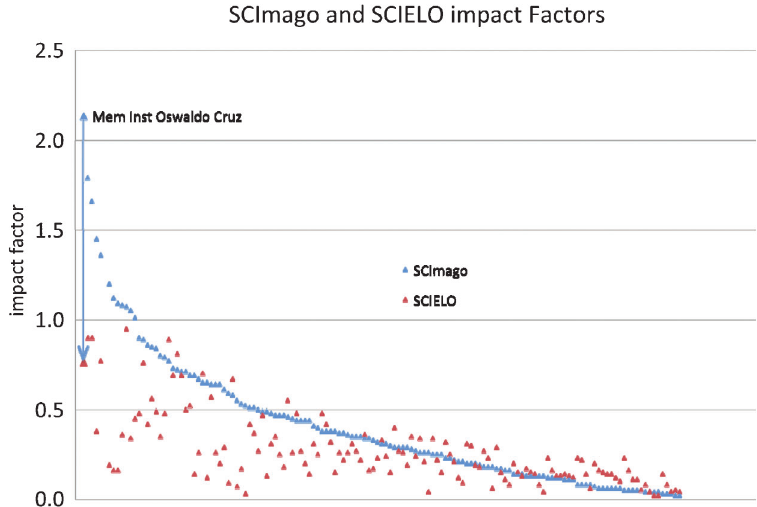
Figura 2 - Fatores de Impacto SCImago e SciELO (2009) para 142 perio´dicos brasileiros representados nos dois ı´ndices com valor maior que zero. Observe-se que quando SCImago . SciELO a diferenc¸a e´ frequentemente grande (como indicado pela seta vertical relativa a`s